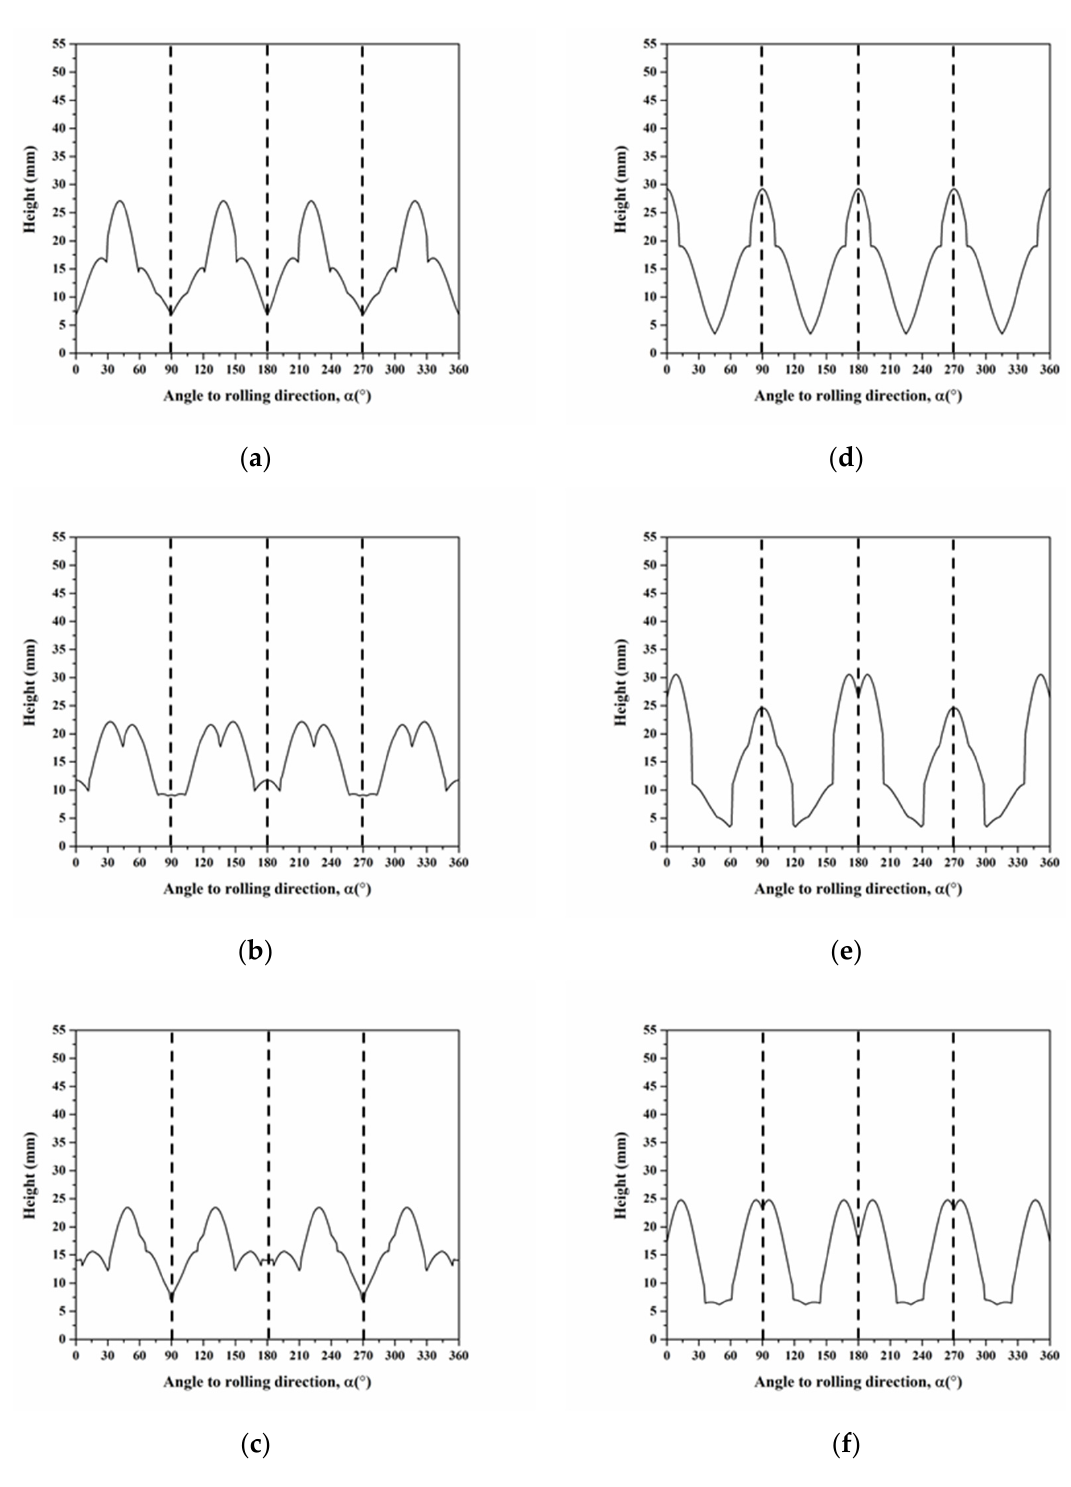
Figure 12. Cup height profiles as a function of the angle for texture components of ( a ) C, ( b ) S, ( c ) B, ( d ) Cube, ( e ) r-Cube, and ( f ) G considering the single slip system. The cup height can be assumed by the contribution of all the texture components in a polycrystalline. Thus, the cup height of ℎ(𝜃) can be summed as the cup height of all texture components 𝑔 in Equation (23) at the angular position by a counterclockwise an- gle 𝜃 measured to the RD direction. The average cup height of ℎ(𝜃) can be expressed as: